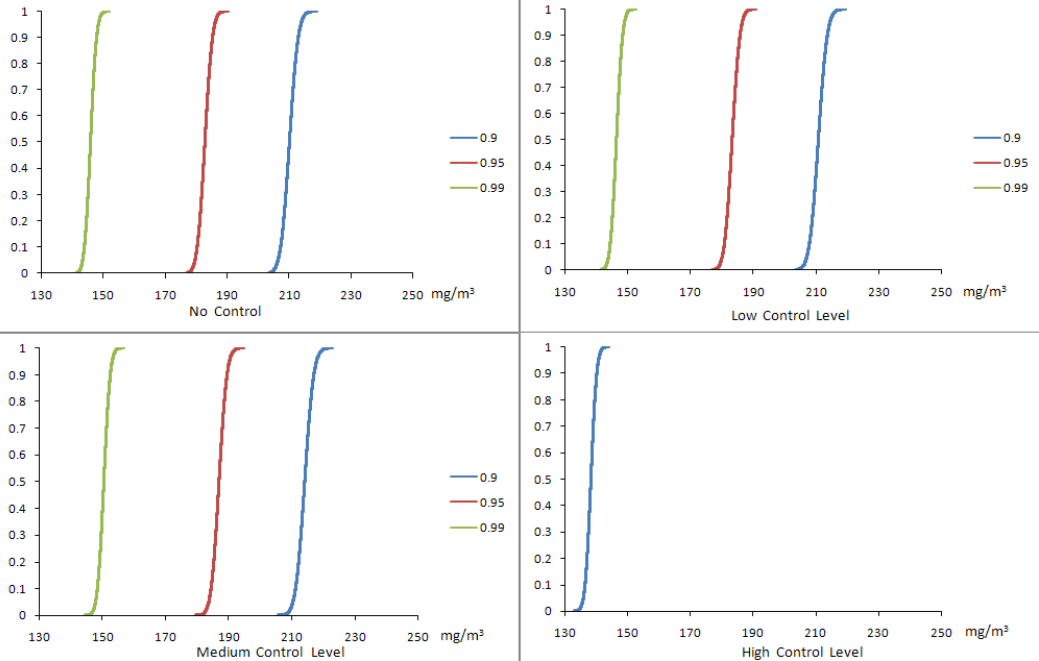
Figure 6. Cumulative probability distributions of CO exposure results from CCP